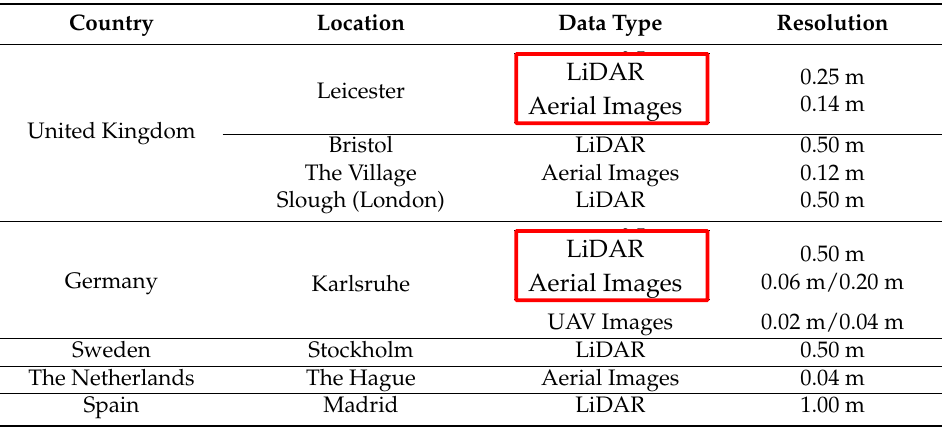
Table 1. Datasets processed by the EAGLE system. For the Karlsruhe test site, two different resolutions were available for classical aerial imagery as well as for unmanned aerial vehicles (UAV); datasets marked in red were used for quality evaluation.